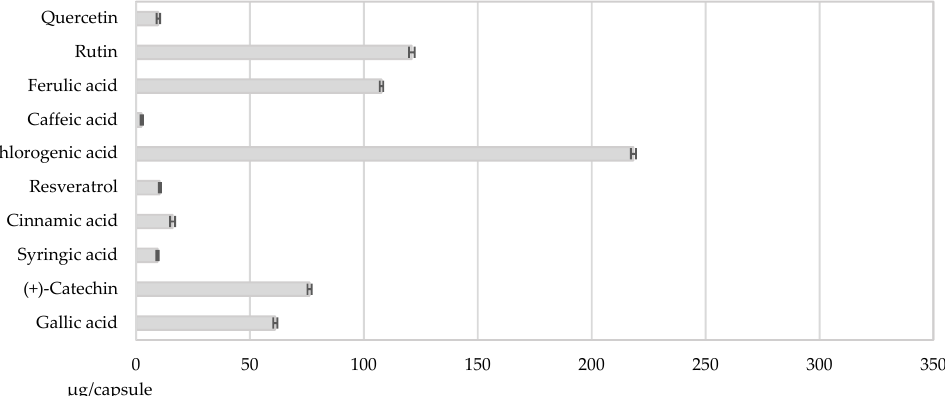
Figure 2. The uniformity of content in phenolic compounds of the capsules analyzed. The percentages of the phenolic compounds analyzed per capsule were as follows: 34.51% chlorogenic acid, 19.13% rutin, 17.03% ferulic acid, 12.04% (+)-catechin, 9.66% gallic acid, 2.54% cinnamic acid, 1.65% resveratrol, 1.50% syringic acid, 1.55% quercetin, and 0.40% caffeic acid.